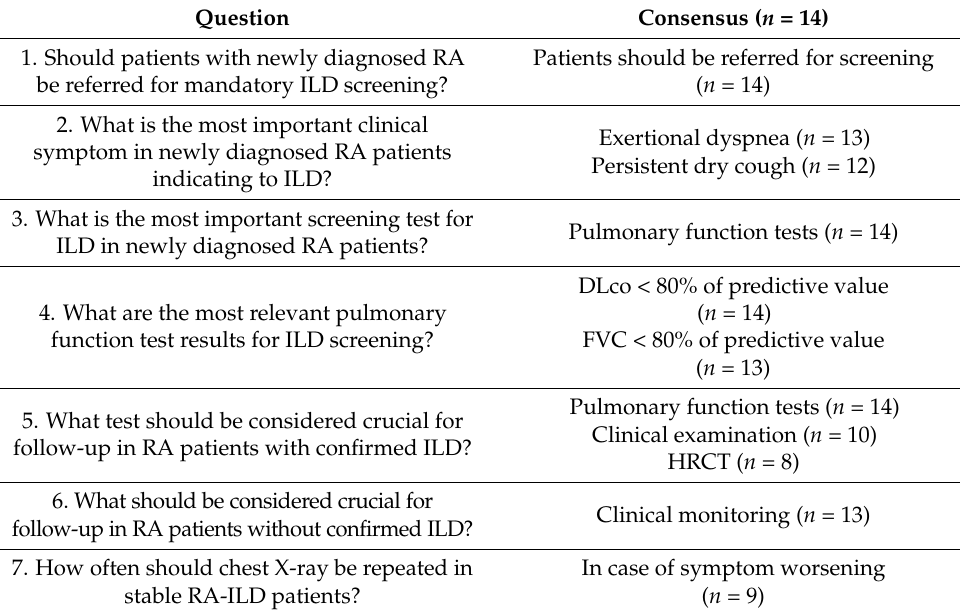
Table 3. Consensus results of the RA questionnaire for screening and monitoring ILD. Question Consensus ( n =